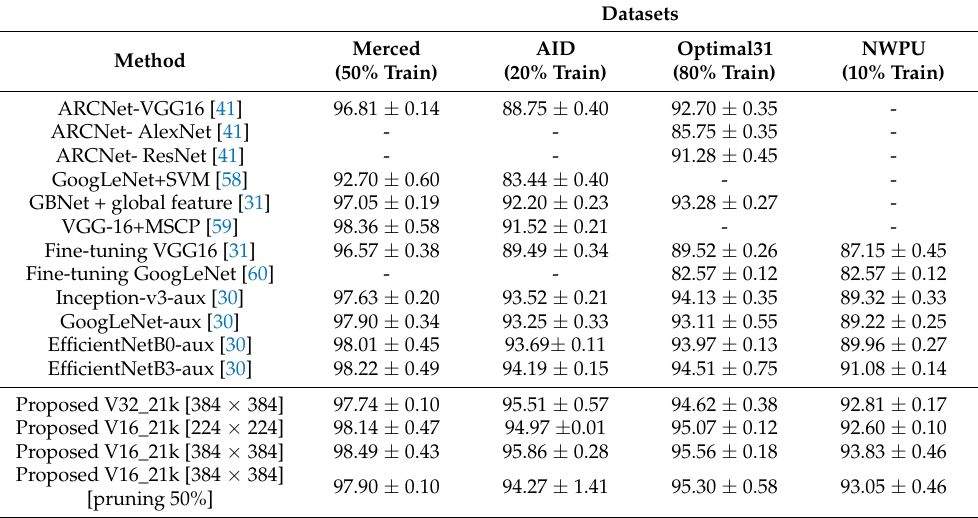
Table 5. Comparison with state-of-the-art